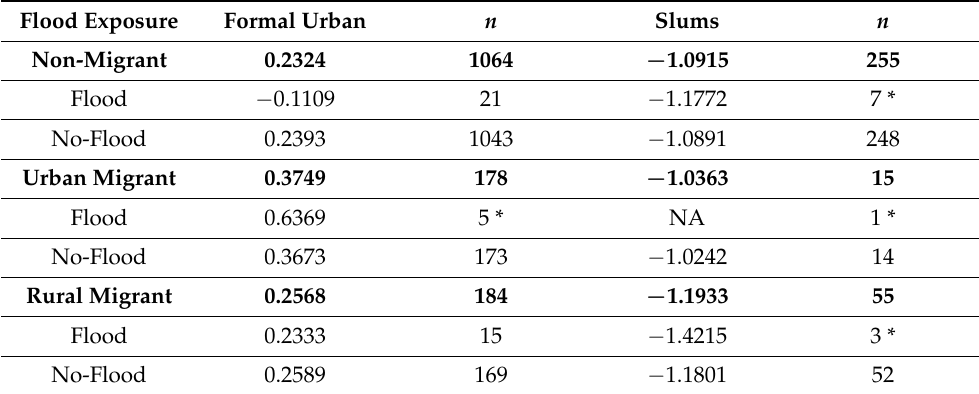
Figure 10. Resilience matrix displaying kernel density estimation of RCI of sub-groups based on the migration characteristic environmental exposure, displaying flood exposure. Table 6. RCI of sub-groups based on the migration characteristic environmental exposure, displaying flood exposure (* low sample